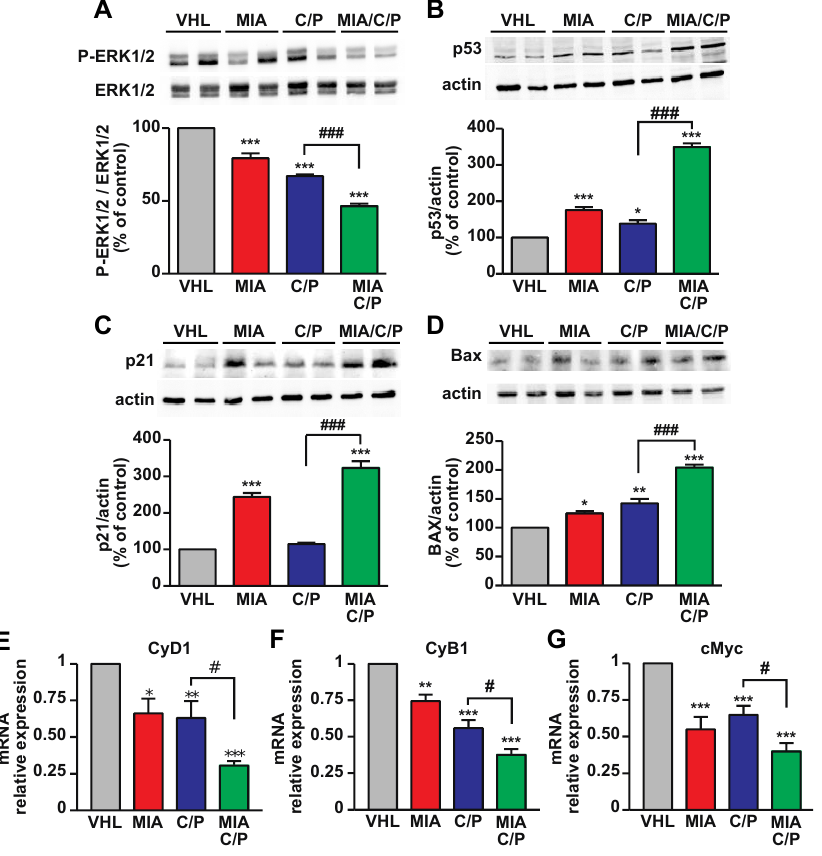
Figure 3. The role of MIA-690 in combination with chemotherapeutic drugs on proliferative and apoptotic pathways and cell cycle regulators in PM tumors. Representative Western blots of phospho- rylated ERK1/2 (P-ERK1/2) ( A ), p53 ( B ), p21 ( C ) and Bax ( D ) in PM specimens (top) of mice treated with vehicle (VHL), MIA-690, cisplatin and pemetrexed (C/P) or the combination of MIA/C/P. Blots, were reprobed with ERK1/2 ( A ) or actin ( B – D ) for normalization (bottom). Results are expressed as percentage of control (VHL) (means ± SEM). * p < 0.05, ** p < 0.01, *** p < 0.001 vs. VHL; ### p < 0.001 by one-way ANOVA and Tukey’s post hoc test ( n = 4 for each group). Real-time PCR analysis for cyclin D1 (CyD1) ( E ), cyclin B1 (CyB1) ( F ) and cMyc ( G ) mRNA in tumor tissues, normalized to 18S rRNA (means ± SEM). * p < 0.05, ** p < 0.01, *** p < 0.001 vs. VHL; # p < 0.05 by one-way ANOVA and Tukey’s post hoc test ( n = 6 for each group).